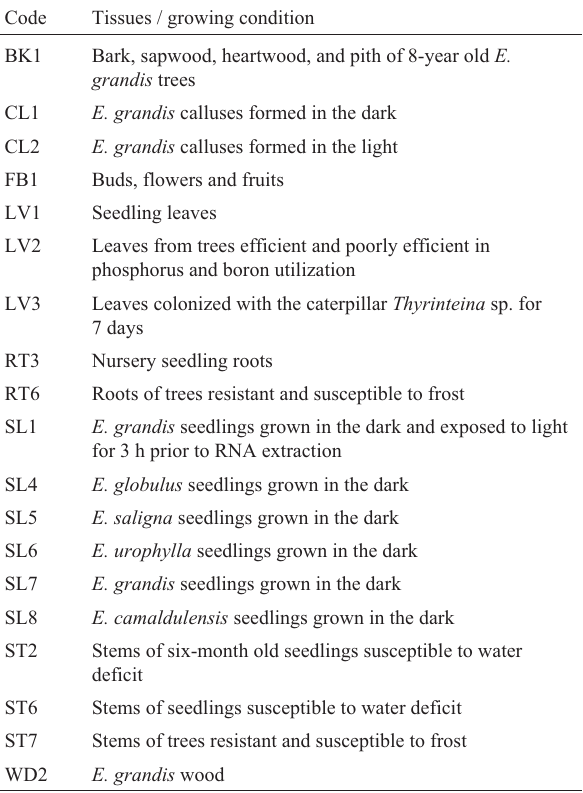
Table 1 - Codes and source tissues of cDNA libraries approved by the FORESTS